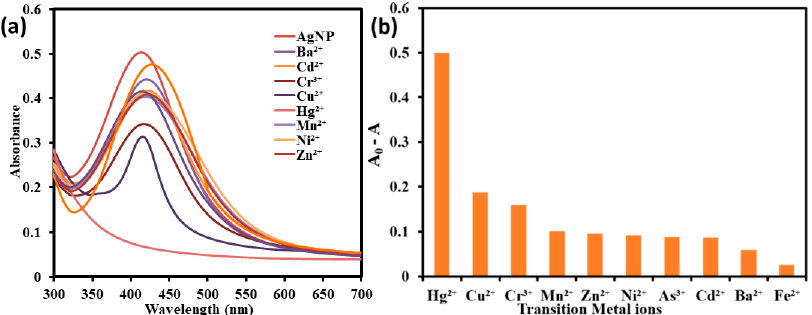
Figure 4. ( a ) UV-vis spectra of AgNPs dispersion with different metal ions and ( b ) absorption ratio of AgNPs with different metal ions.